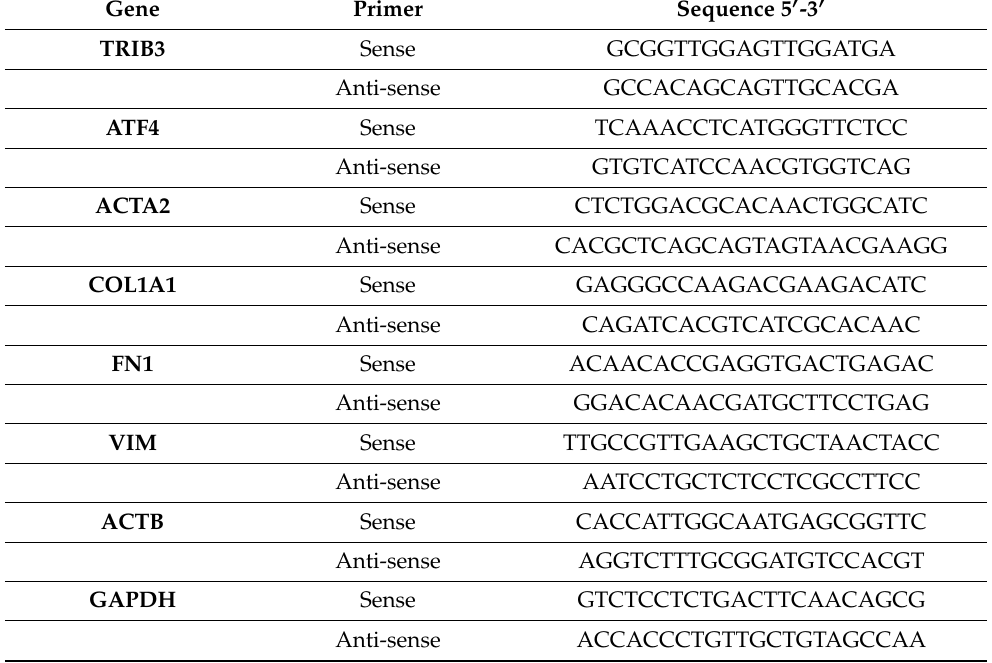
Table 2. Primers used in the study